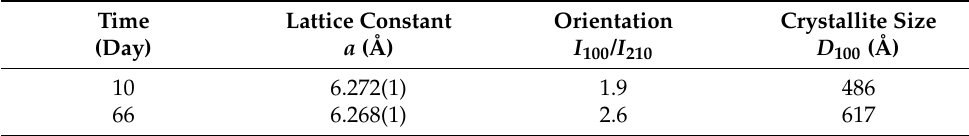
Table 4. Changes of crystallographic data of perovskite